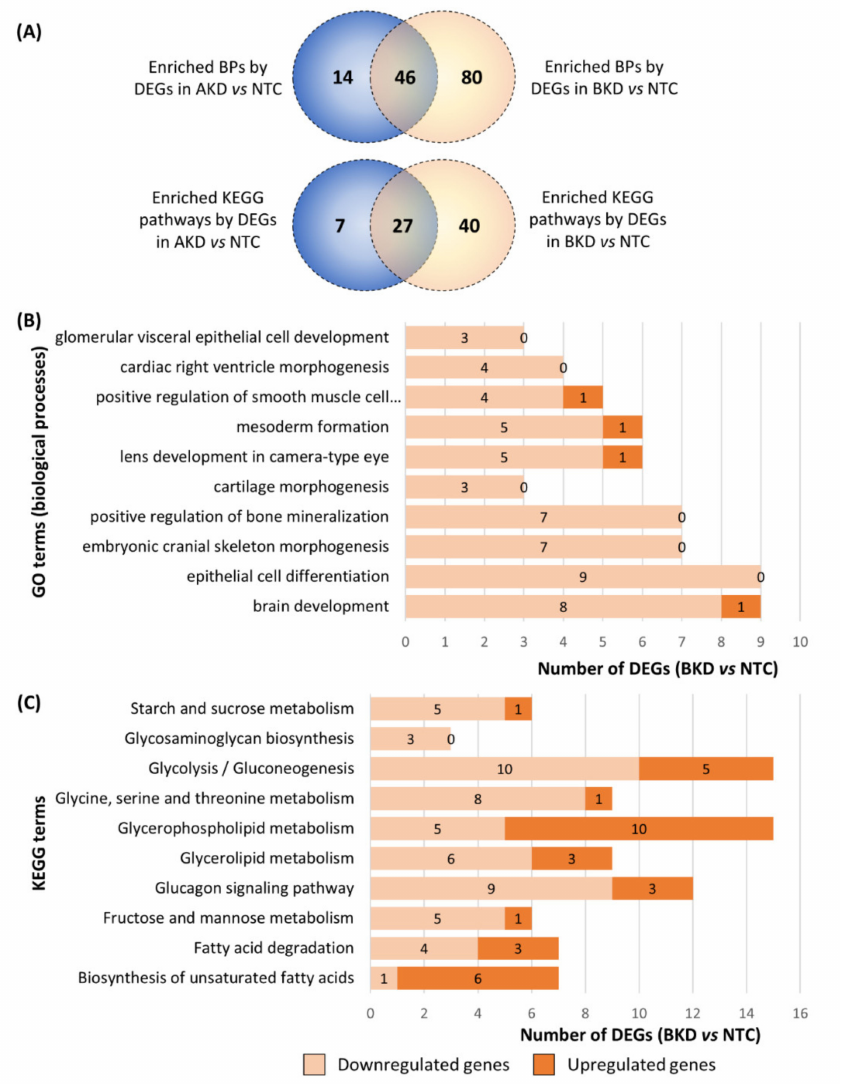
Figure 5. BPs and KEGG pathway enriched only in BKD TE. ( A ) Venn plot of BPs and KEGG pathways significantly enriched by The DEGs in AKD and BKD TE. 80 BPs and 40 KEGG pathways were enriched only in BKD TE. The figure also shows ( B ) 10 BPs related to fetal development and ( C ) 10 KEGG pathways related to metabolism enriched only in BKD TE. A complete list of KEGG pathways significantly enriched by the DEGs in AKD and BKD TE is provided in Tables S2 and